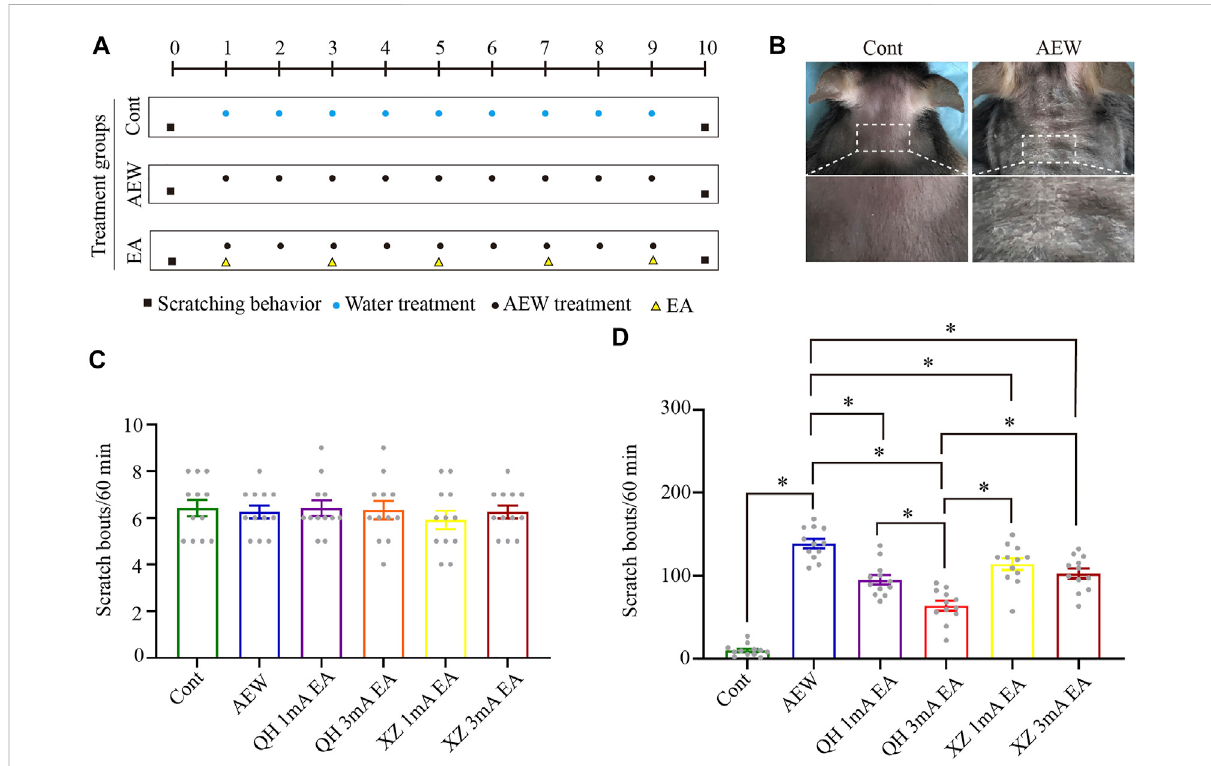
FIGURE 1 EffectofEAatdifferentintensitiesanddifferentacupuncturepointsonspontaneousscratchingbehavior. (A) Aschematicshowingtheprotocol of experiments and EA treatment. (B) The comparison of neck skin between the AEW group and control group. (C) The baseline scratch bouts in control, AEW, QH 1 mA EA, QH 3 mA EA, XZ 1 mA EA and XZ 3 mA EA groups. (D) The scratch bouts in control and AEW mice and the effects of